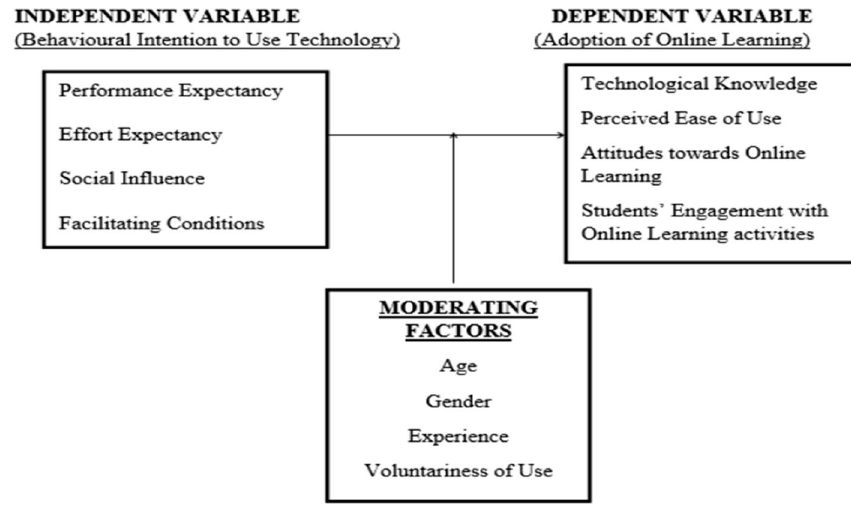
Fig. 1 Conceptual framework of the study